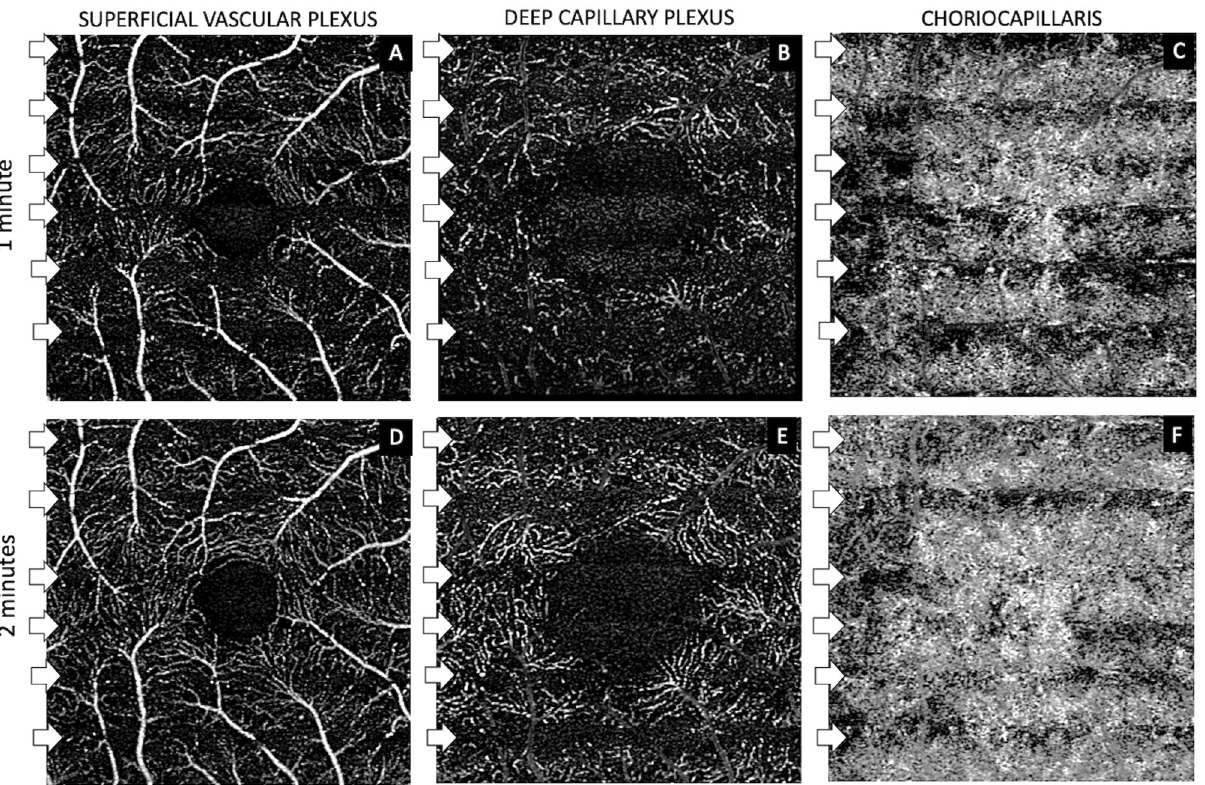
Figure 2. Stripe dark band patterns across OCTA scans at 1-min and 2-min post-intravitreal injection. Evenly distributed horizontal stripe patterns (white arrows) across each OCTA scan at the superficial vascular plexus (SVP) ( A , D ), deep capillary plexus (DCP) ( B , E ) and choriocapillaris (CC) layers ( C , F ) was detected. These bands represent episodic flow signal as the intra ocular pressure (IOP) dropped below the instantaneous pressure in the arteries and veins. These 6–7 bands persisted for about 2–3 min post injection and if timed according to the duration of scan (approximately 3 s) would imply a heart rate of approximately 120 beats per minute, which was in agreement with the anesthesia record (101–128 beats per minute). These bands were more prominent and persistent in the DCP ( B , E ) than in the SVP ( A , D ) suggesting a lower perfusion pressure in the